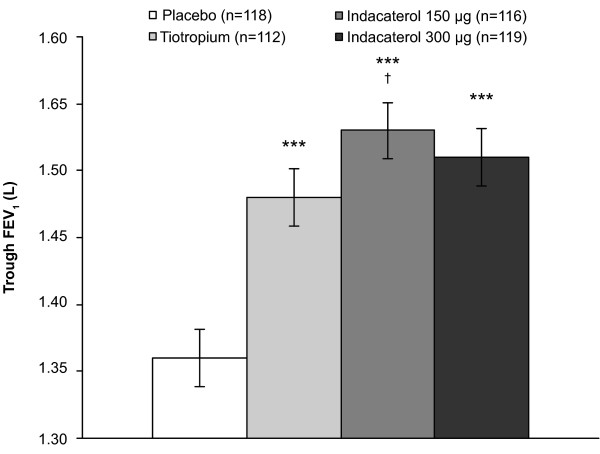
24-h post-dose (trough) FEV1 (L) after 14 days of treatment (mITT population). Data are LSM ± SE. ***p < 0.001 vs placebo; †p = 0.043 vs tiotropium. FEV1, forced expiratory volume in 1 s